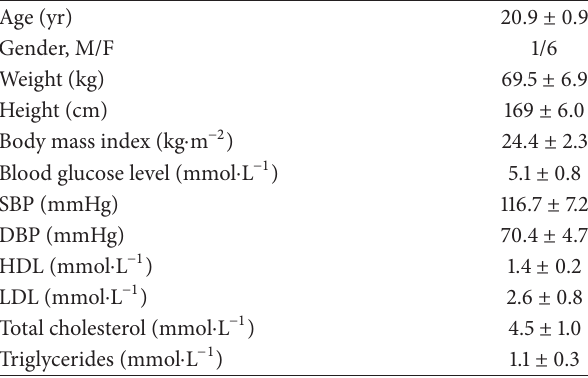
Table 1: Subject